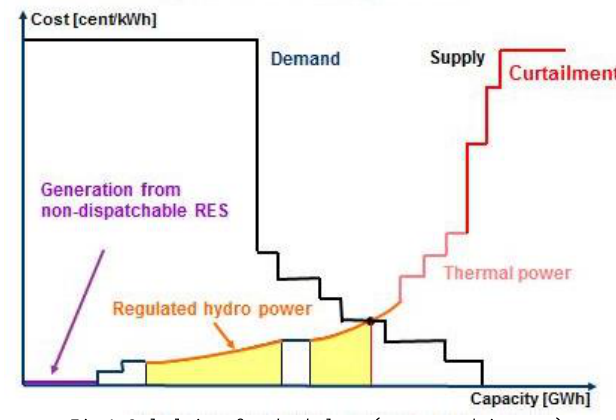
Fig. 1. Calculation of market balance (per area and time step).